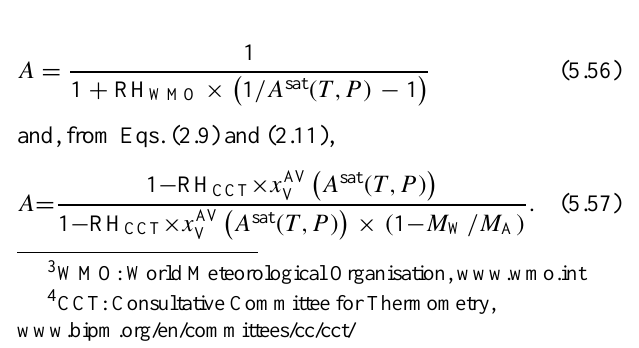
3 WMO: World Meteorological Organisation, www.wmo.int 4 CCT: Consultative Committee for Thermometry, www.bipm.org/en/committees/cc/cct/